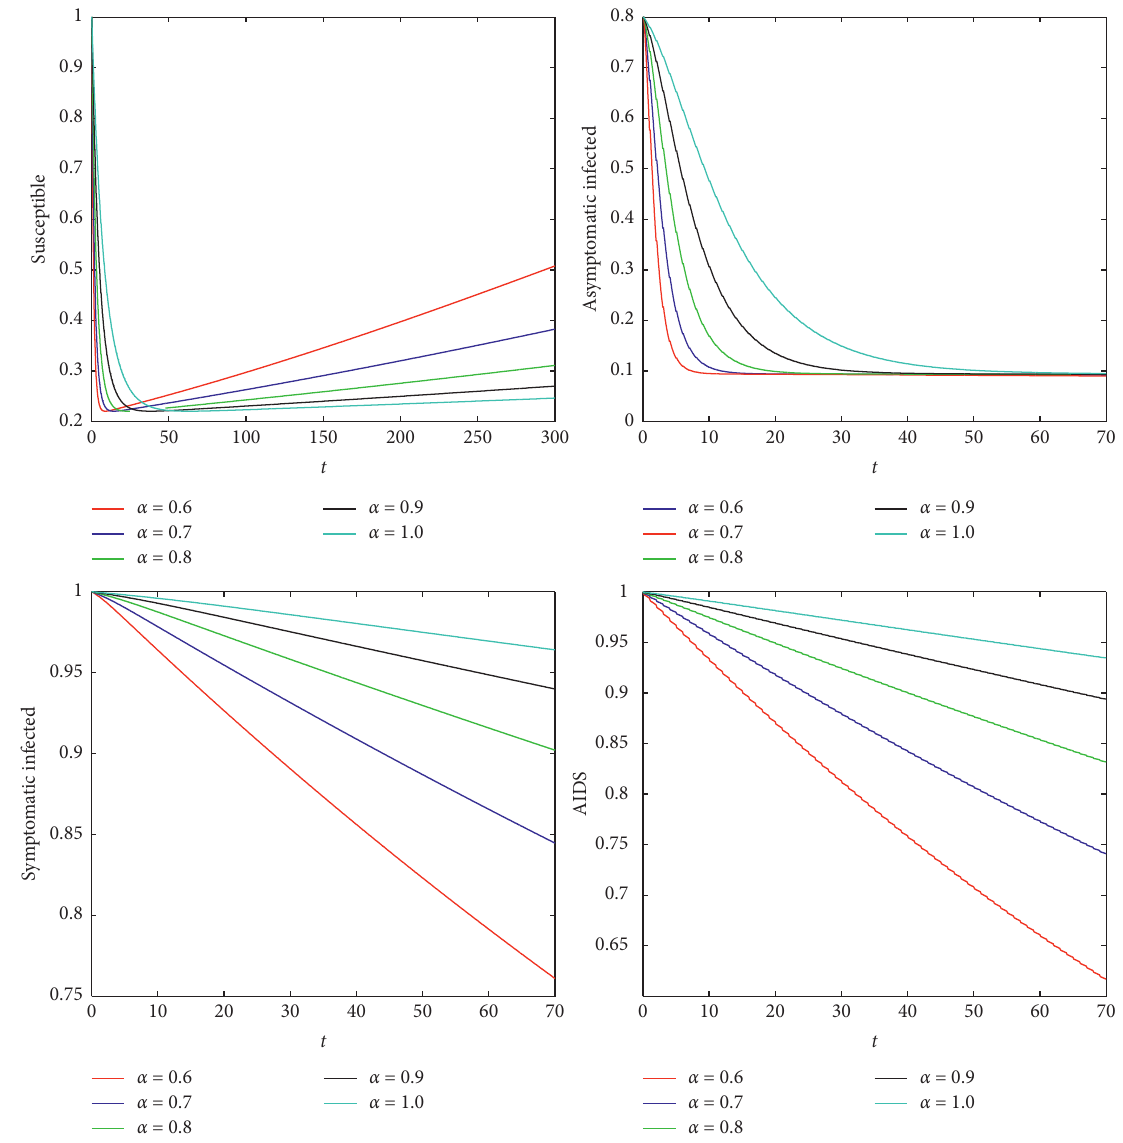
Figure 2: The dynamics of system (1) for different fractional order α .